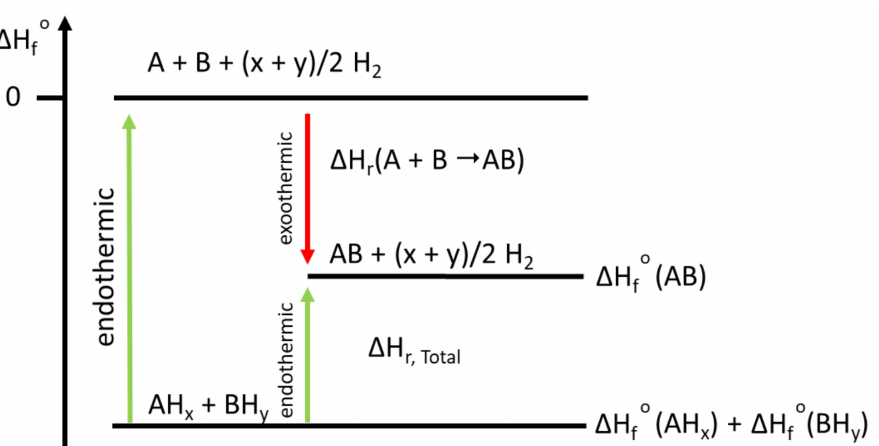
Figure 4. Schematic enthalpy diagram depicting the RHC approach applied to a two-component system (AH x and BH y ), which, upon dehydrogenation, forms a single compound (AB) plus hydrogen. ◦ = standard enthalpy of ∆ H f